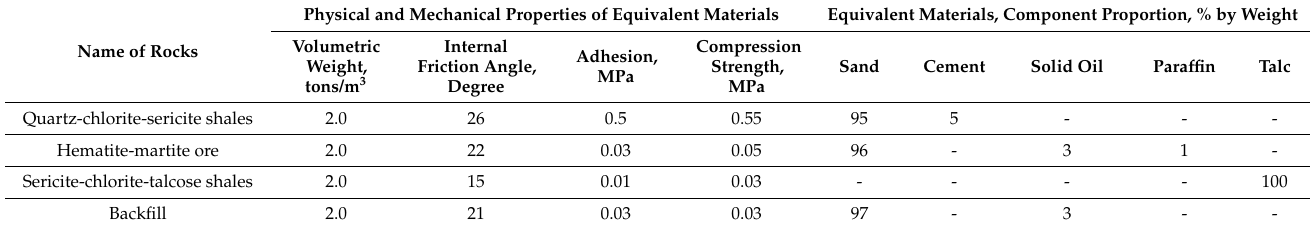
Table 1. Physical and mechanical properties of rocks and equivalent